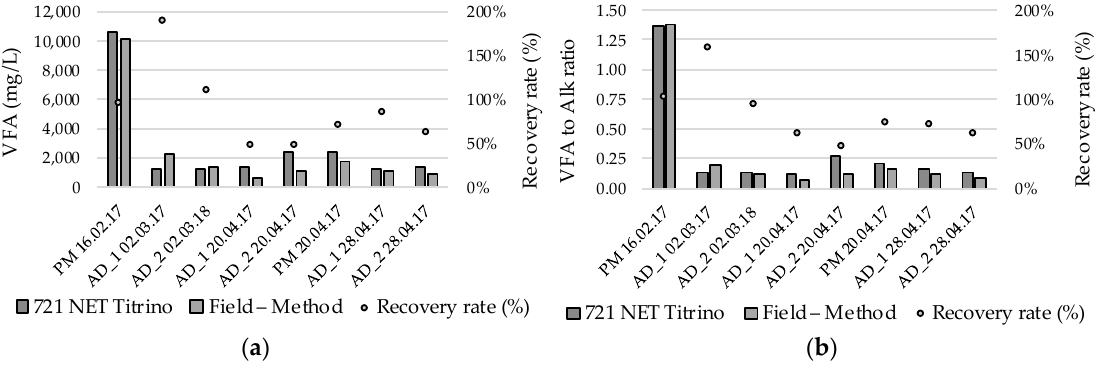
Figure 4. Modification of Volatile Fatty Acid (VFA)/Bicarbonate Alkalinity (Alk) titration; comparisons of ( a ) VFA results and ( b ) the complete VFA/Alk ratio PM—pig manure; AD—anaerobic digestor effluent.